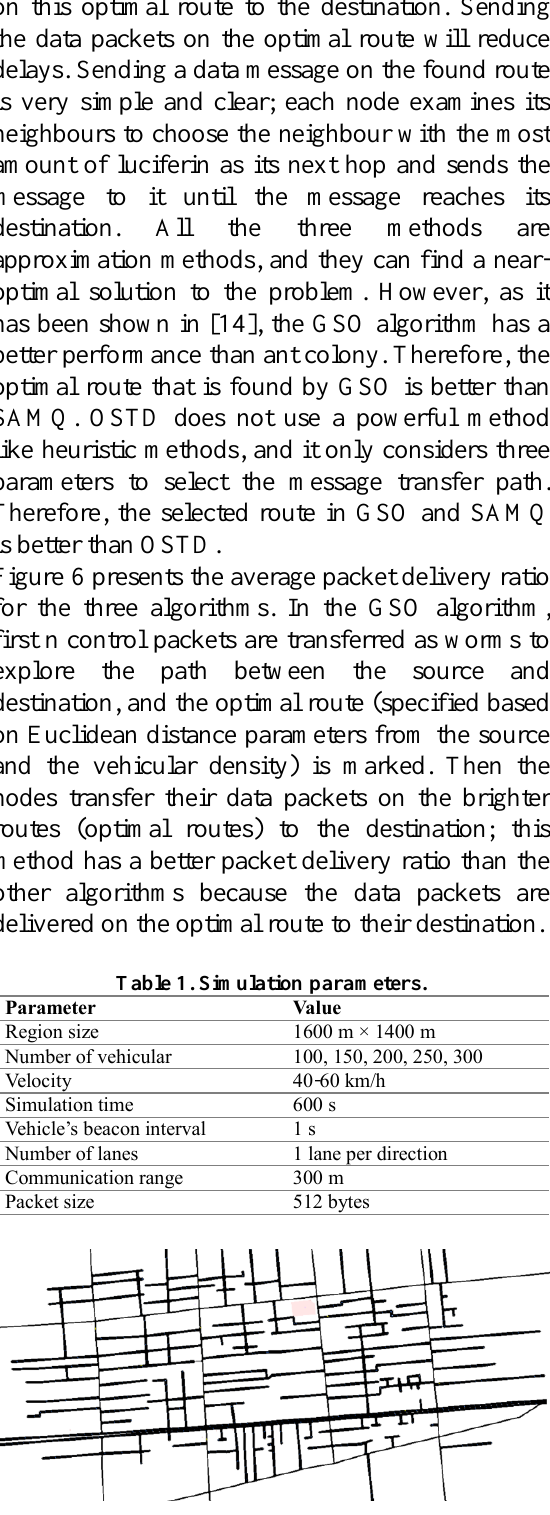
Figure 4. Simulation